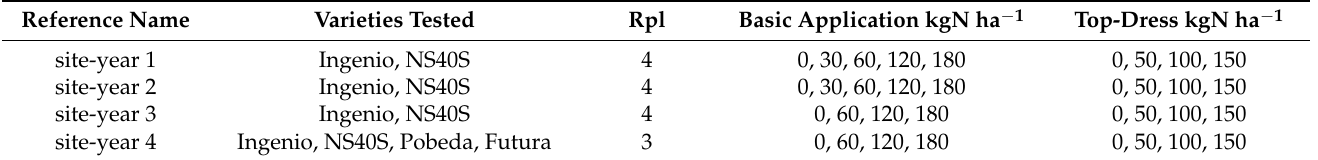
Table 3. Experimental plan for the four site-years of the